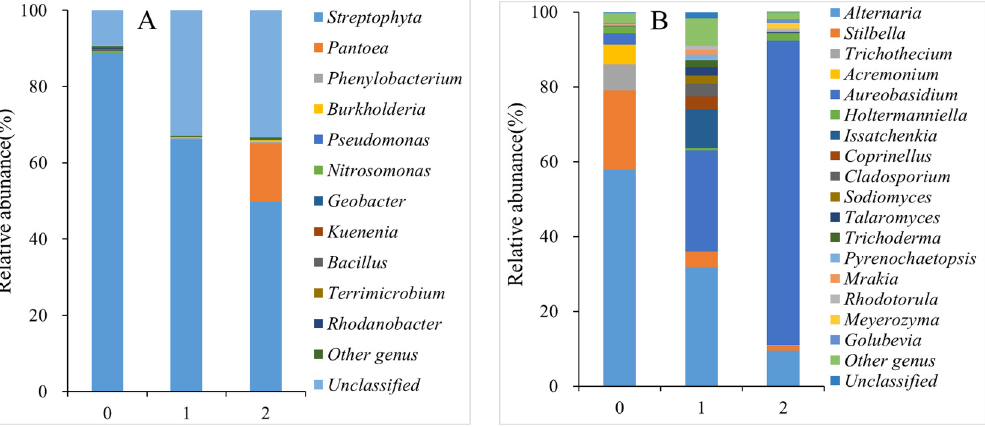
Figure 6. Bacterial ( A ) and fungus ( B ) diversity of peaches. 0, control at time 0; 1, control after 35 days; 2, combination after 35 days.